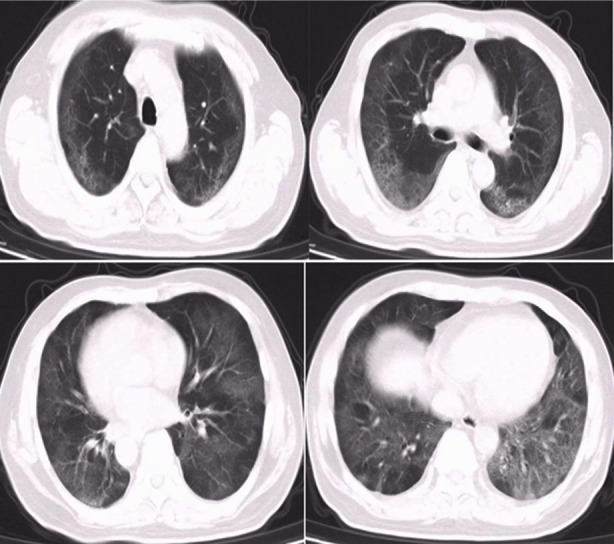
Chest CT scan results after 15 days of hospitalization. Multiple ground-glass lesions were observed, and pulmonary fibrosis was found locally. D-dimer and hs-CRP levels reduced to 0.62 μg/ml and 14.6 mg/L, respectively.